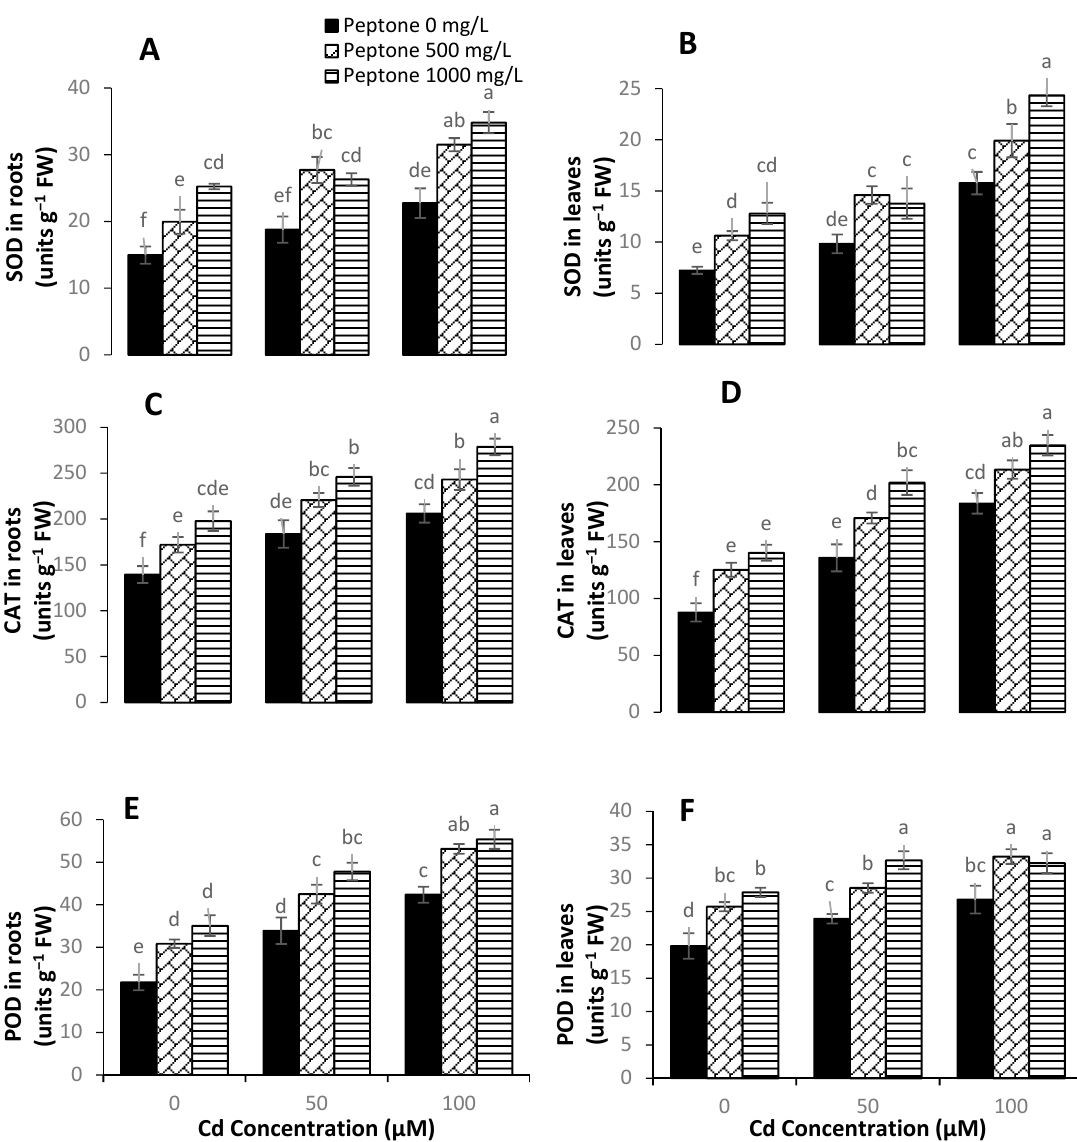
Figure 5. The influence of the foliar application of peptone (0, 500, and 1000 mgL − 1 ) on superoxide dismutase (SOD) in roots ( A ), SOD in leaves ( B ), catalase (CAT) in roots ( C ), CAT in leaves ( D ), peroxidase (POD) in roots ( E ) and POD in leaves ( F ) of spinach plants grown under Cd stress. Values represent the means of four replicates with standard deviations. Letters on the bar indicate the significant differences between given treatments at p < 0.05.